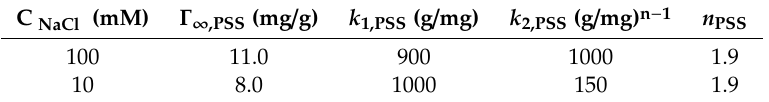
Figure 1. Adsorption isotherms of poly(styrenesulfonate) (PSS) onto α -Al 2 O 3 at two NaCl concentrations (pH 4, adsorption time 120 min, mass ratio of PSS to alumina 20 mg / g). Points are experimental data while solid lines are the results of the two-step adsorption model. Error bars show standard deviations of three replicate. Table 1. Fit parameters for the adsorption isotherms onto Al 2 O 3 at di ff erent NaCl concentration (pH 4). The maximum adsorbed amount Γ ∞ ,PSS , the equilibrium constants k 1,PSS , k 2,PSS for first layer and multilayer, respectively, n the number of clusters of PSS